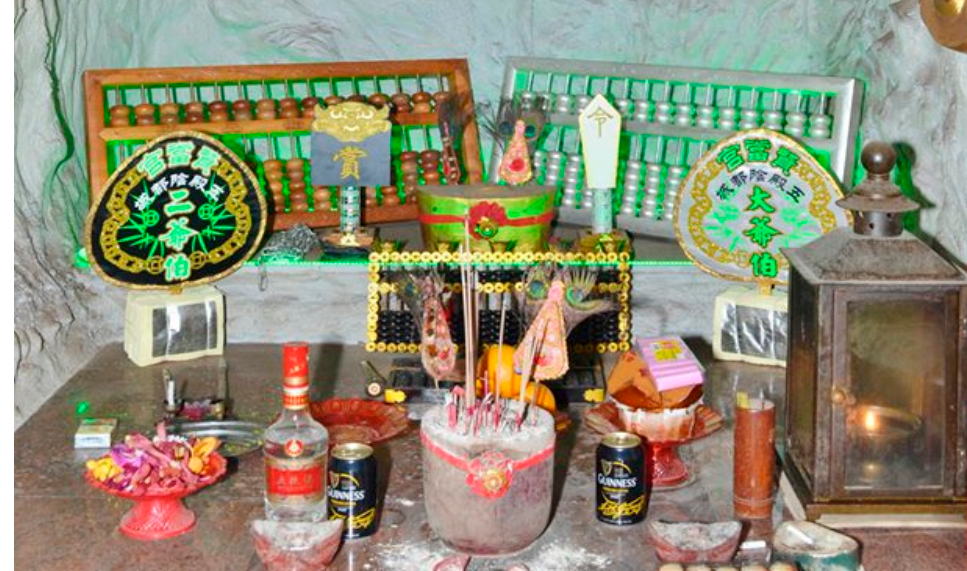
Figure 2. Altar to the Underworld gods in Hiang Tong Keng temple. The characters on the black and white fans placed in front of the abacus read: “Hiang Tong Keng. Second Grand Uncle” and “Hiang Tong Keng. First Grand Uncle” respectively (Source: Author).